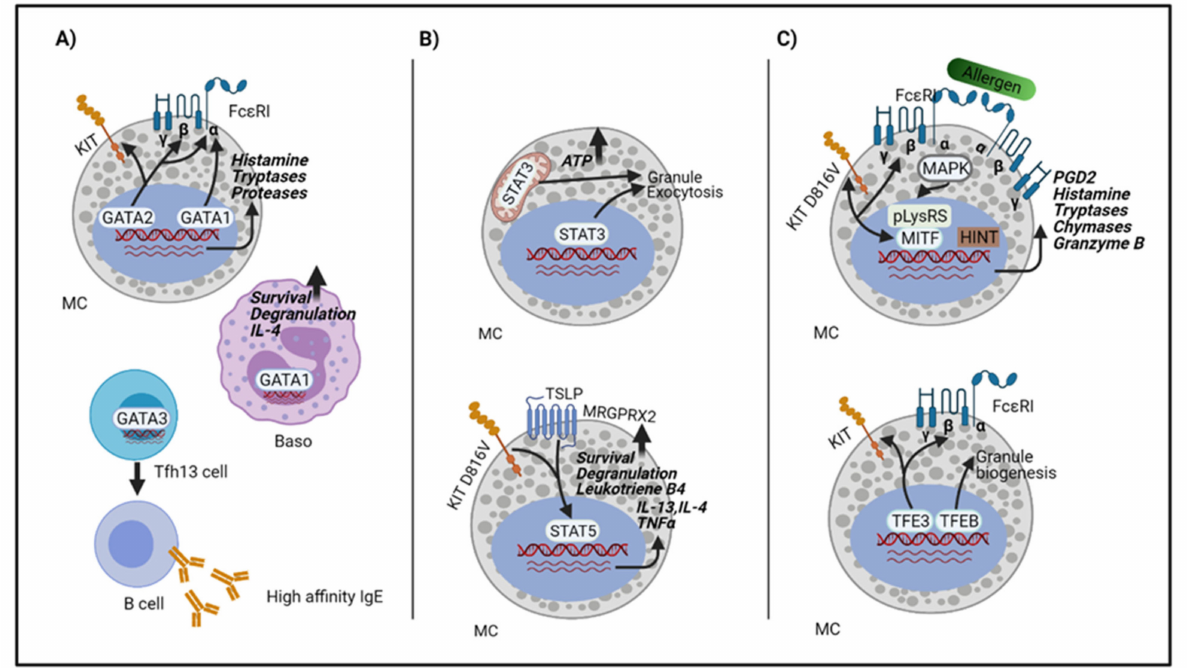
Figure 1. GATA, STAT, and MITF family in anaphylaxis. ( A ) GATA family plays a central role in mast cell activity. GATA2 is key for mast cell activity. Fc ε RI α , Fc ε RI β , and KIT expression is regulated by GATA2, while Fc ε RI α is also controlled by GATA1 [52,53]. GATA1 regulates Il-4 production in basophils [50]. GATA1 and GATA2 regulate tryptases (including mTMT, mMCP6, and mMCP7). Furthermore, GATA2 regulates histamine and proteases (Cpa3, Mcpt4, Mcpt8, Cma1) synthesis [27,54]. GATA3 defines a Tfh13 population involved in anaphylactic IgE production [59]. ( B ) STAT family is downstream of key receptors and controls mast cell activity. STAT3 increases IgE-dependent degranulation in a canonical and non-canonical pathways increasing ATP production in mitochondria [74]. STAT5 is downstream of KIT D816V in mastocytosis, it increases cell survival, degranulation, leukotriene synthesis and stabilizes IL-13, IL-4, and TNF α mRNA [92,93]. Thymic stromal lymphopoietin (TSLP) binding to MRGPRX2 increases STAT5 activity [94]. ( C ) IgE-LysRS-MITF axis in anaphylaxis. MITF is downstream of KIT and IgE signaling [114,118]. MITF and KIT are reciprocally regulated [114,115]. Upon IgE-Ag, LysRS is phosphorylated by the MAP kinase pathway and translocated into the nucleus. LysRS activity in the nucleus dissociated MITF–HINT complex, inducing MITF transcriptional activities [118]. TFE3 is important for IgE–dependent pathway anaphylaxis by regulating Fc ε RI and KIT receptor expression [120]. TFEB is a master transcription factor for mast cell granule